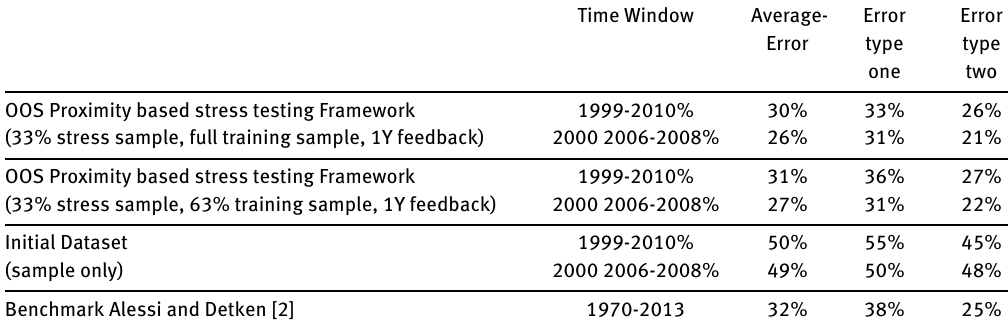
Table 8: Comparison of the results of the proposed proximity based stress testing framework against a suitable benchmark and against the dataset with only the sample included and no application of the framework (see section 4.1.2). The Errors are shown in % of the underlying